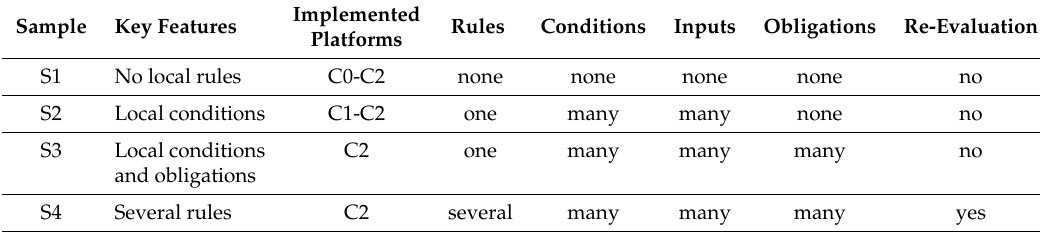
Table 2. Policy instance sample groups and currently implemented platforms, excluding the proposed access control